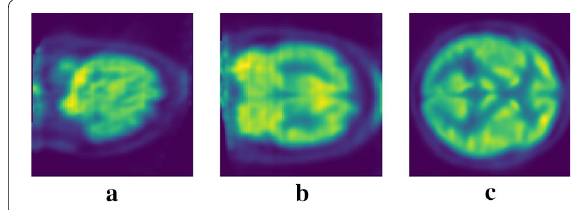
Fig. 1 Example of brain PET images. a Sagittal view, b coronal view, c axial